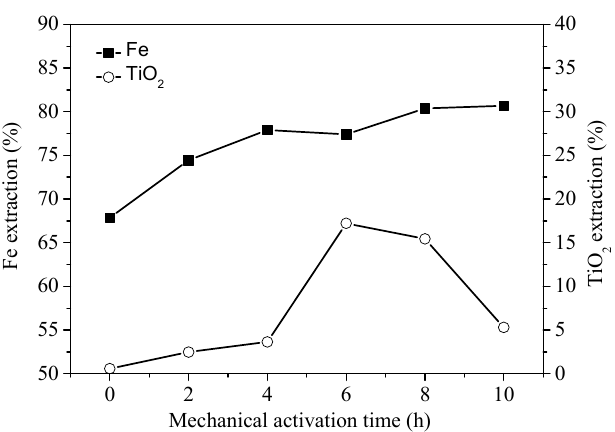
Figure 8. Rate of iron and titanium dioxide extractions with different mechanical activation times.